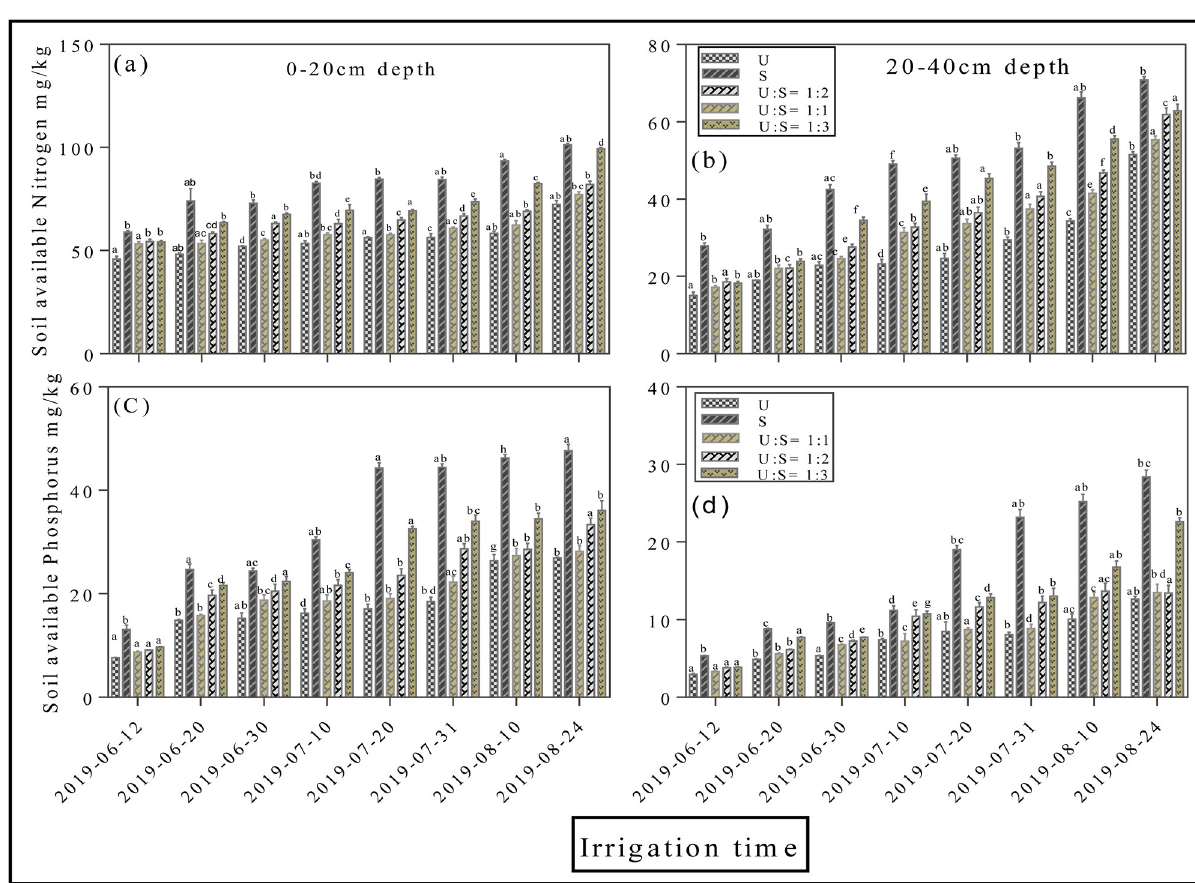
Fig 6. Effects of different mixing ratio irrigation on soil available nitrogen (mg/kg) and soil available phosphorus (mg/kg): Fig (4a) and (4b) represents soil available nitrogen at depth of 0–20 cm and 20–40 cm; Fig (4c) and (4d) represents soil available phosphorus at depth of 0–20 cm and 20–40 cm. Data were presented as the mean ± standard error (SE) of three replicates at a significance level of p < 0.05 (based on ANOVA).